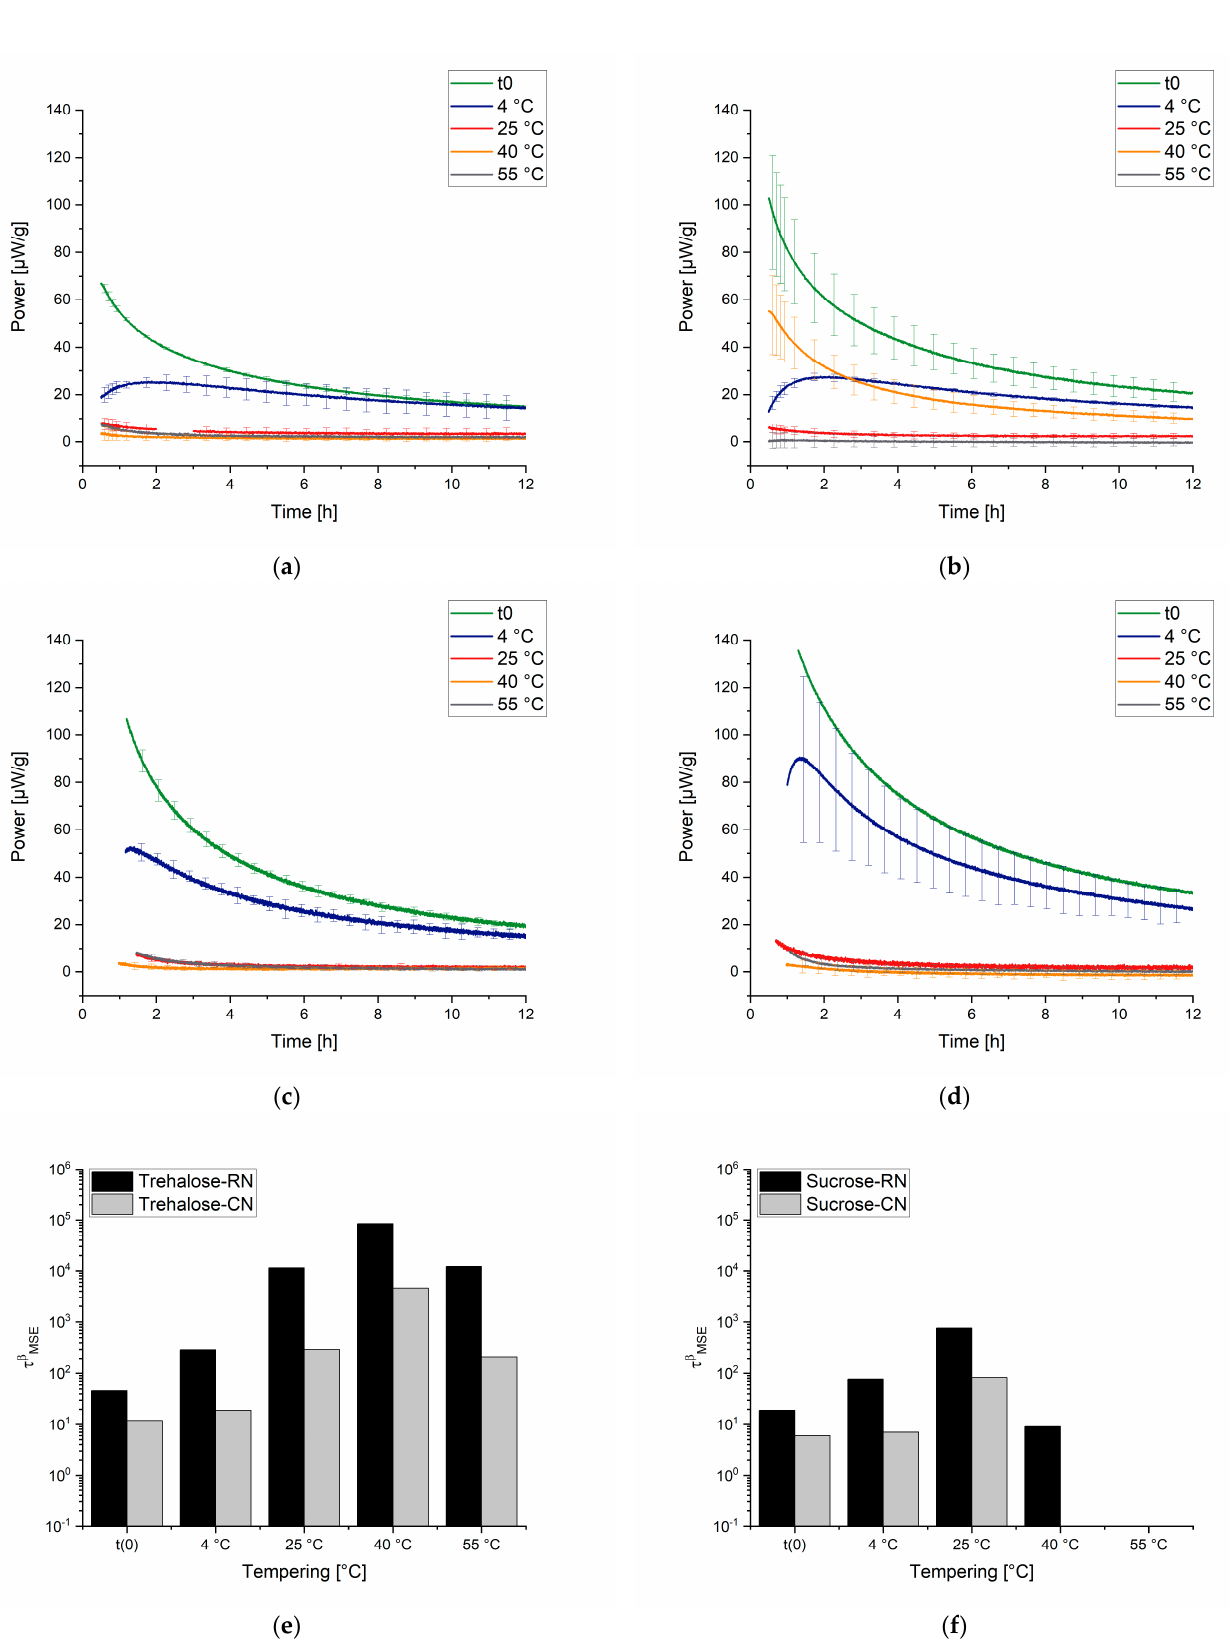
Figure 9. Isothermal measurements performed at 25 °C. Freshly prepared sample (green), 4 °C tempered sample (blue), 25 °C tempered sample (red), 40 °C tempered sample (orange), 55 °C tempered sample (grey). ( a ) Trehalose-RN, ( b ) Sucrose-RN, ( c ) Trehalose-CN, ( d ) Sucrose-CN, ( e , f ) calculated values of τ β [ h ] . Missing bars indicate unsuccessful curve fitting.